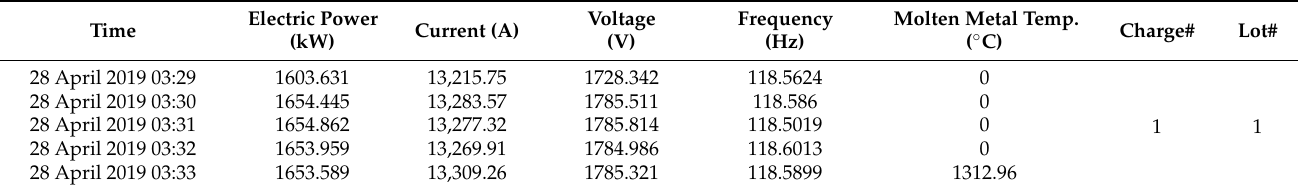
Table 2. Extracted TSWP for melting